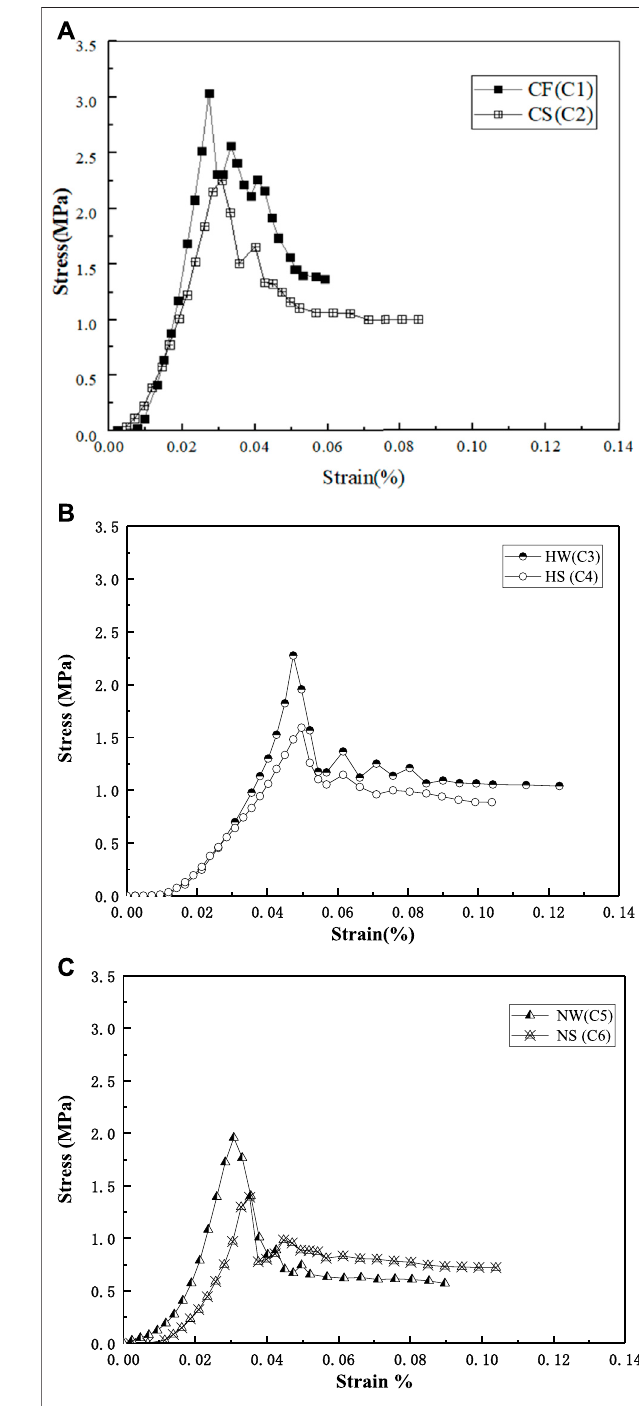
FIGURE 5| Tensile splitting strength (TSS) in Group C offreshwater and seawater environment. (A) Group C CaCl 2 ; (B) Ca(CH 3 COO) 2 ; (C) Ca(NO 3 ) 2 .